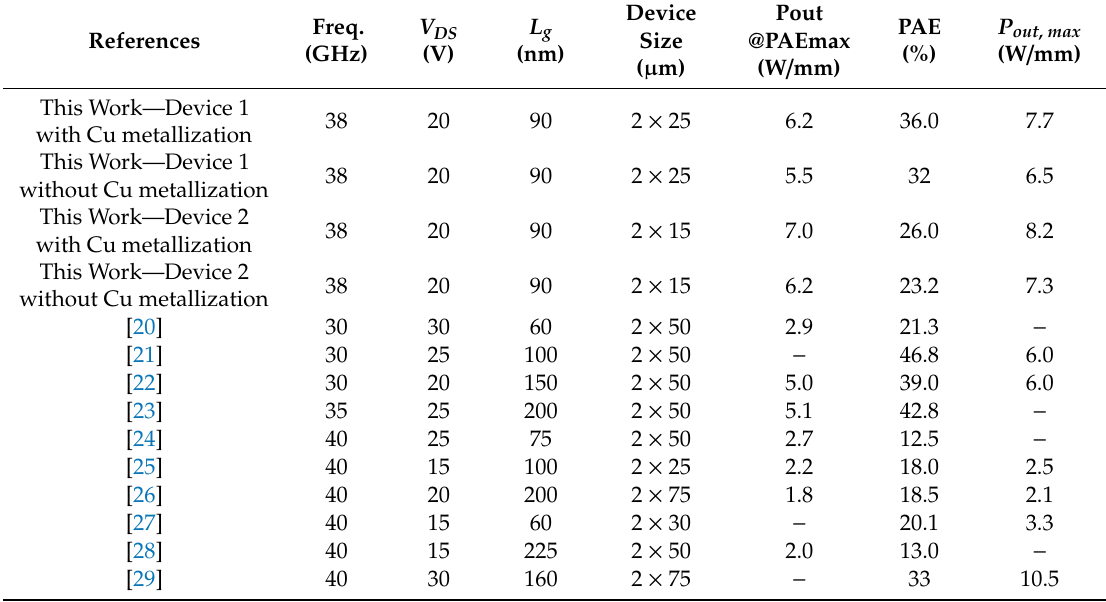
Table 1. Power performance comparison of the Cu metallization with other